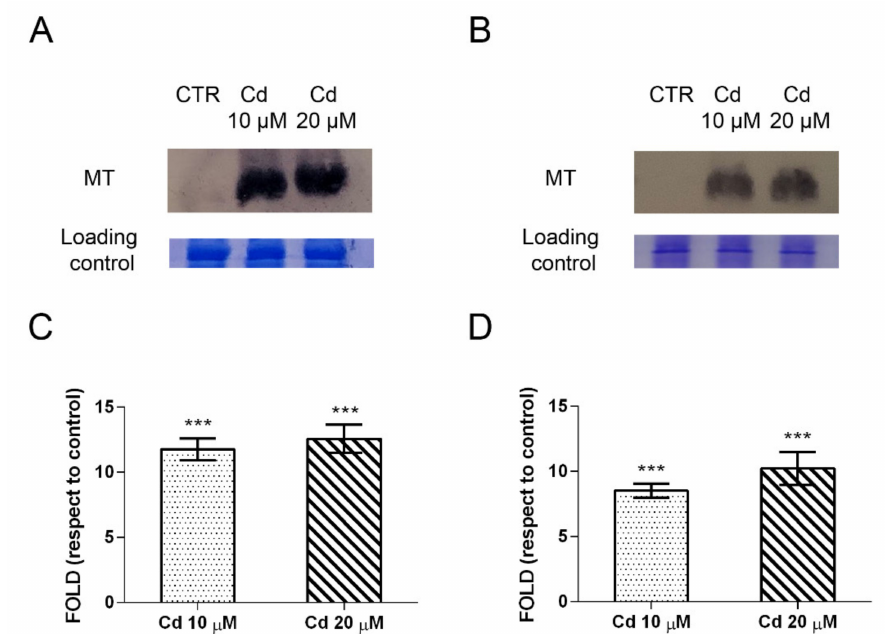
Figure 5. Metallothioneins expression in human lung cancer cells (A549) and human neuronal cells (SH-SY5Y) exposed to cadmium. Representative Western blot performed on A549 ( A ) and SH-SY5Y ( B ) samples exposed to 10 µ M and 20 µ M Cd for 24 h. Densitometric analyses performed with Scion Image Software are in the panels ( C , D ). Values are presented as means ± standard error (SE) of three different experiments. Significantly different from control: *** p < 0.001 (Dunnett’s